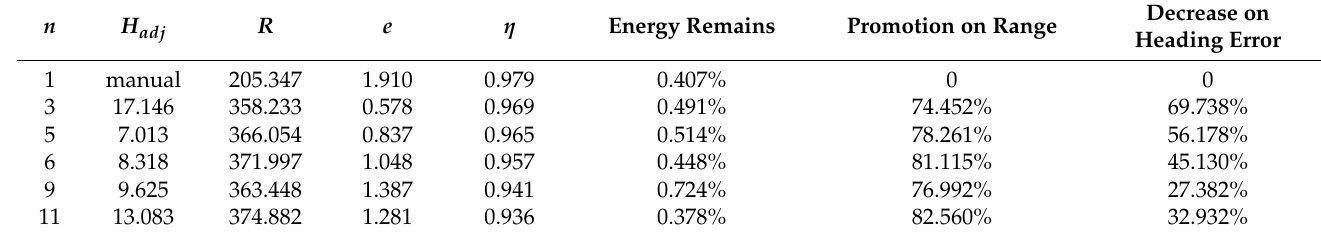
Table 3. Navigation index comparison between sea trial data and several typical Pareto solutions.